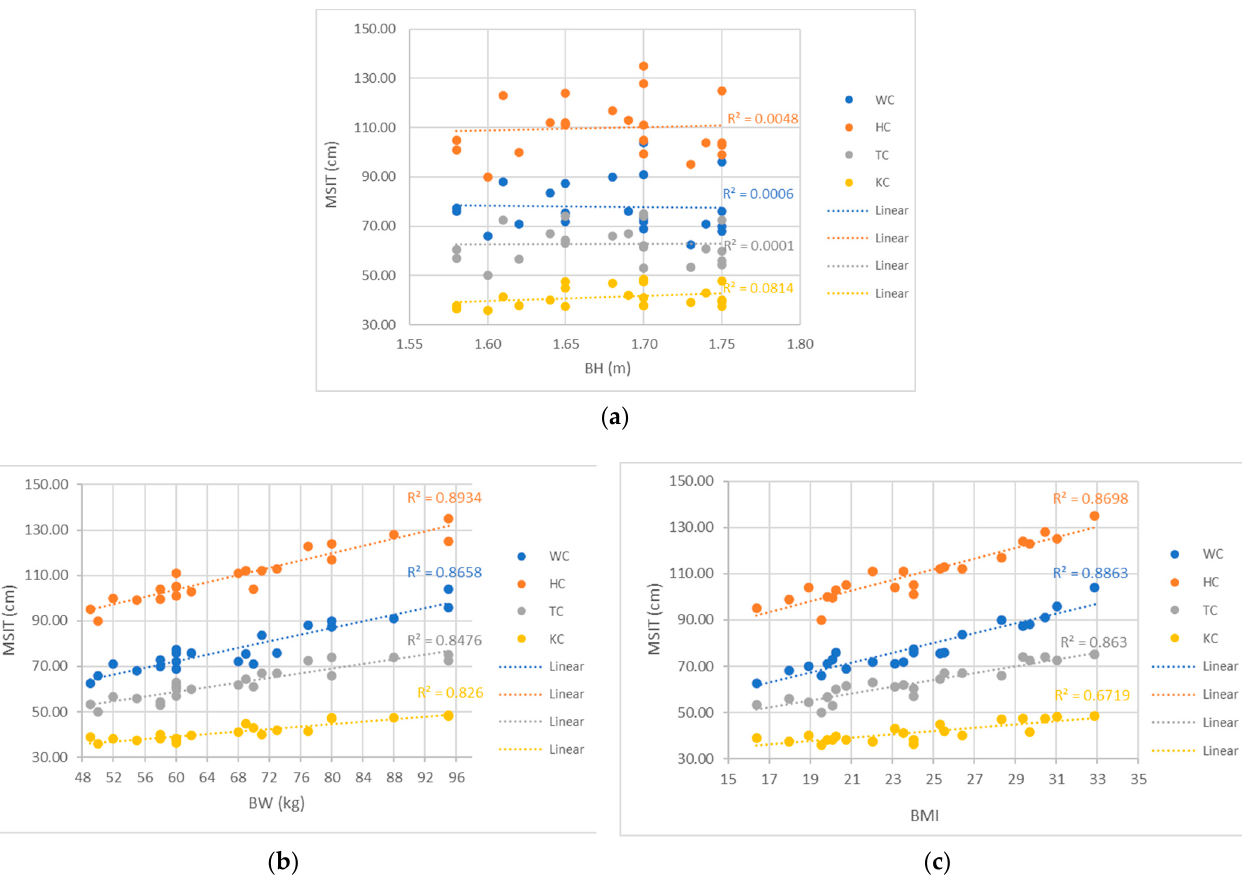
Figure 5. Influence of participants’ basic data on observed measurements of body circumferences in a sitting posture (MSIT): ( a ) body height, ( b ) body weight, ( c ) body mass index. Table 6. Pearson correlation coefficients between participants’ basic data and their body